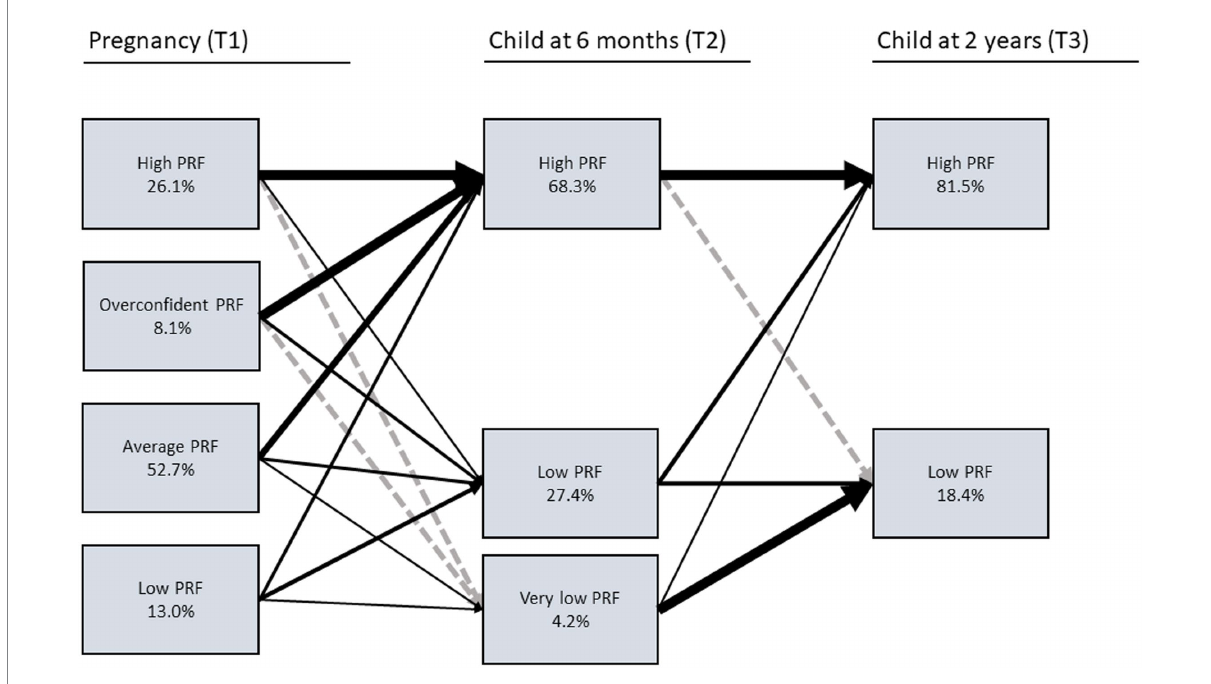
FIGURE 2 Transitions between the maternal PRF profiles. The width of the arrows depict the probability of the transitions (larger arrows indicate higher transitional probability). Broken arrows indicate no transitions between the